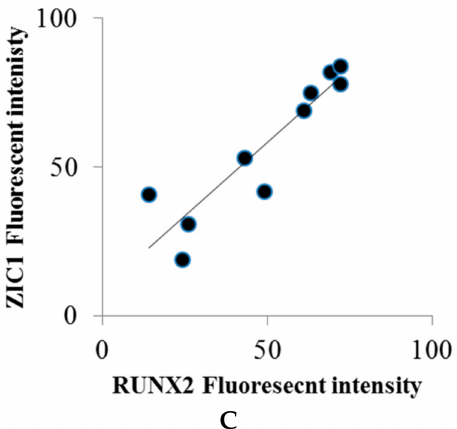
Figure 5. ( A , B ) The fluorescence intensity of RUNX2 and ZIC1 nuclei (expressed as mean, grey values) from ROPs cultured in osteogenic medium, maintained either as static control or subjected to FSS at the end of day 3. ( C ) The plot shows a direct relationship between translocation of RUNX2 and ZIC1 to the nucleus when subjected to